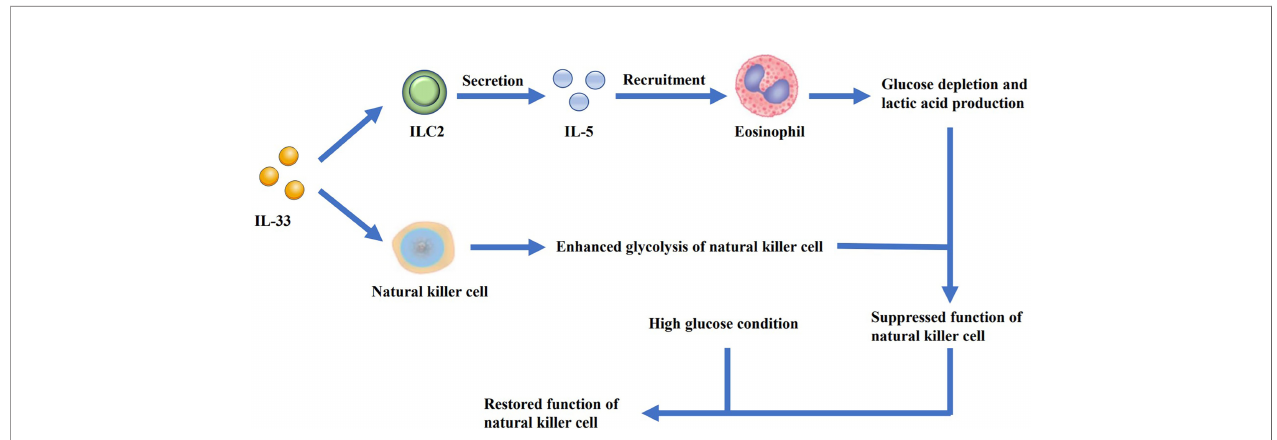
FIGURE 2 | IL-33 promotes the secretion of IL-5 by ILC2s and leads to the recruitment of eosinophils, resulting in glucose depletion and lactic acid production. At the same time, IL-33 can enhance the glycolysis of NK cells. As the glucose is depleted and the lactic acid is accumulated, the function of NK cells is suppressed. However, when additional glucose is added, the function of the cells can be